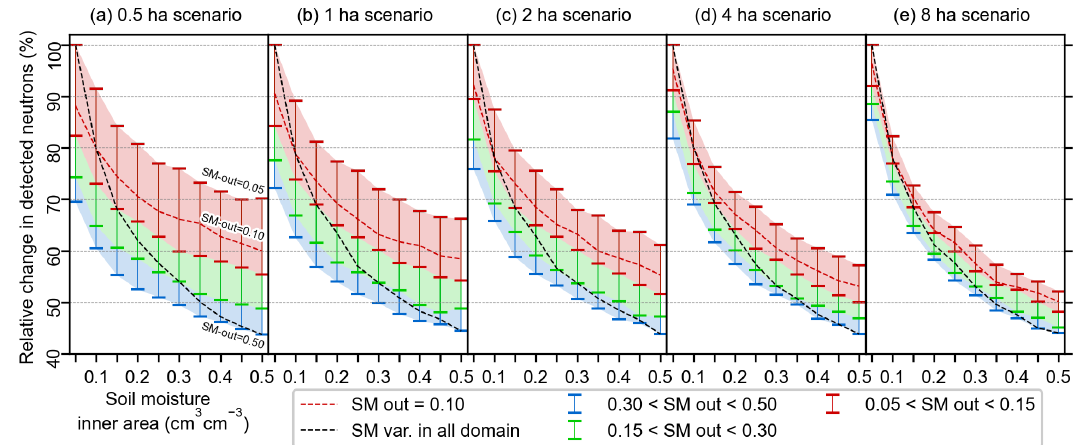
Figure 9. Relative changes in detected neutrons due to SM variations in (a) 0.5, (b) 1, (c) 2, (d) 4, and (e) 8ha irrigated areas. The dashed black line shows SM variations that are homogeneous within the simulated domain. The dashed red lines and the error bars indicate SM variations that occur only within the irrigated area for a different SM in the outer